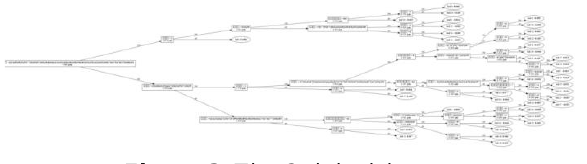
Figure 4. Loss function